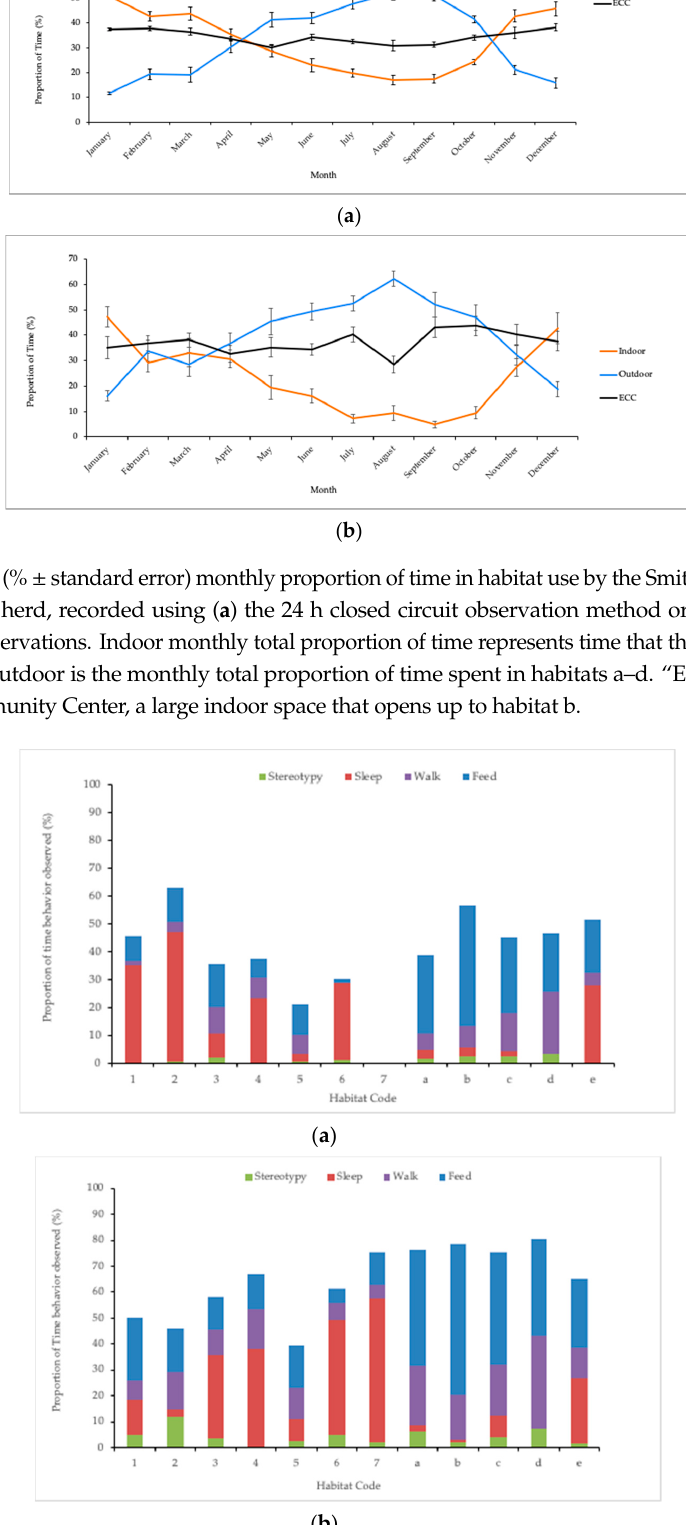
( c ) Figure 8. Activity budget representing proportion of time spent exhibiting four key behaviors: “Stereotypy”, “Sleep”, “Walk”, and “Feed”. Observations made on three elephants through 24 h interval monitoring are represented and include: ( a ) Ambika, ( b ) Swarna, and ( c ) Spike. Habitats include indoor suites 1–7 and Elephant Community Center and outdoor habitats a–e. Habitat use data were combined with activity budgets to identify the locations of key behaviors such as “Stereotypy”, “Sleep”, “Feed”, and “Walk” for each elephant. Spike was observed to spend more time exhibiting stereotypies in Suites 1–7 than in the habitats or ECC. Spike and Bozie exhibited stereotypic behavior more often indoors than outdoors, whereas Shanthi exhibited stereotypic behavior nearly indiscriminately across habitats (Figure 8a–c). Recumbence data were examined to determine most commonly used areas for each individual elephant to lay down (Figure 9). Spike exhibited clear sleeping location preferences that emerged in